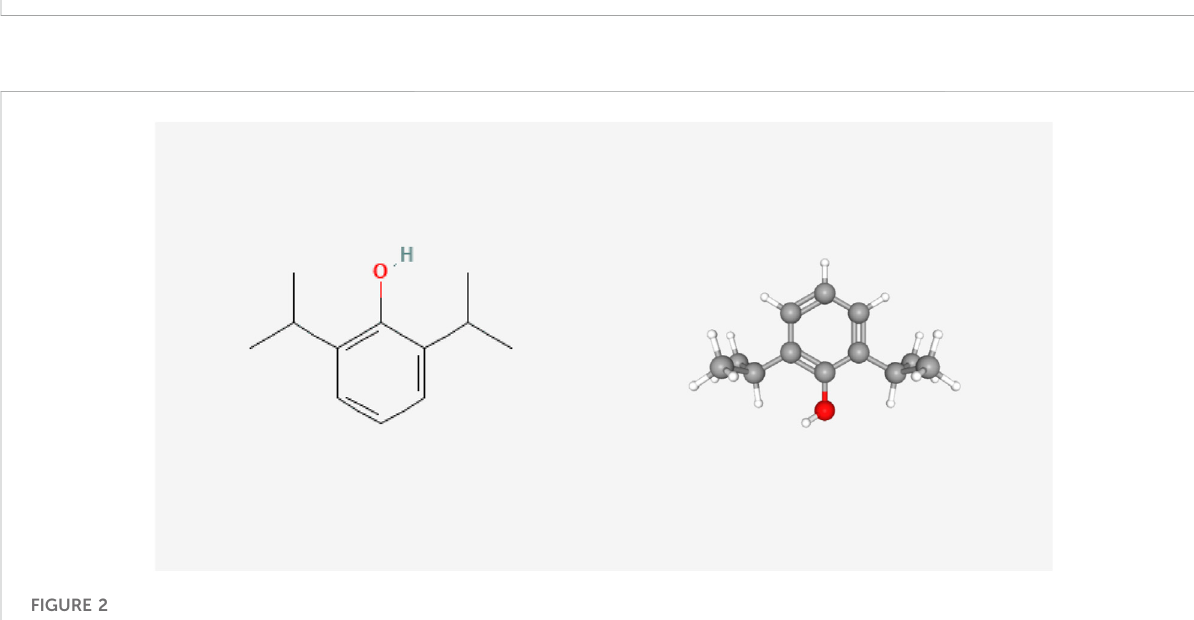
FIGURE 1 Effects of propofol on the tumor cells and tumor microenvironment. On one hand, propofol may directly act on tumor cells, exerting anti- tumor and pro-tumor effects, and regulating drug resistance. On the other hand, propofol may act indirectly on the tumor microenvironment by anti-angiogenesis, regulating immunity, reducing in fl ammation, and remodeling the extracellular matrix (By Figdraw).